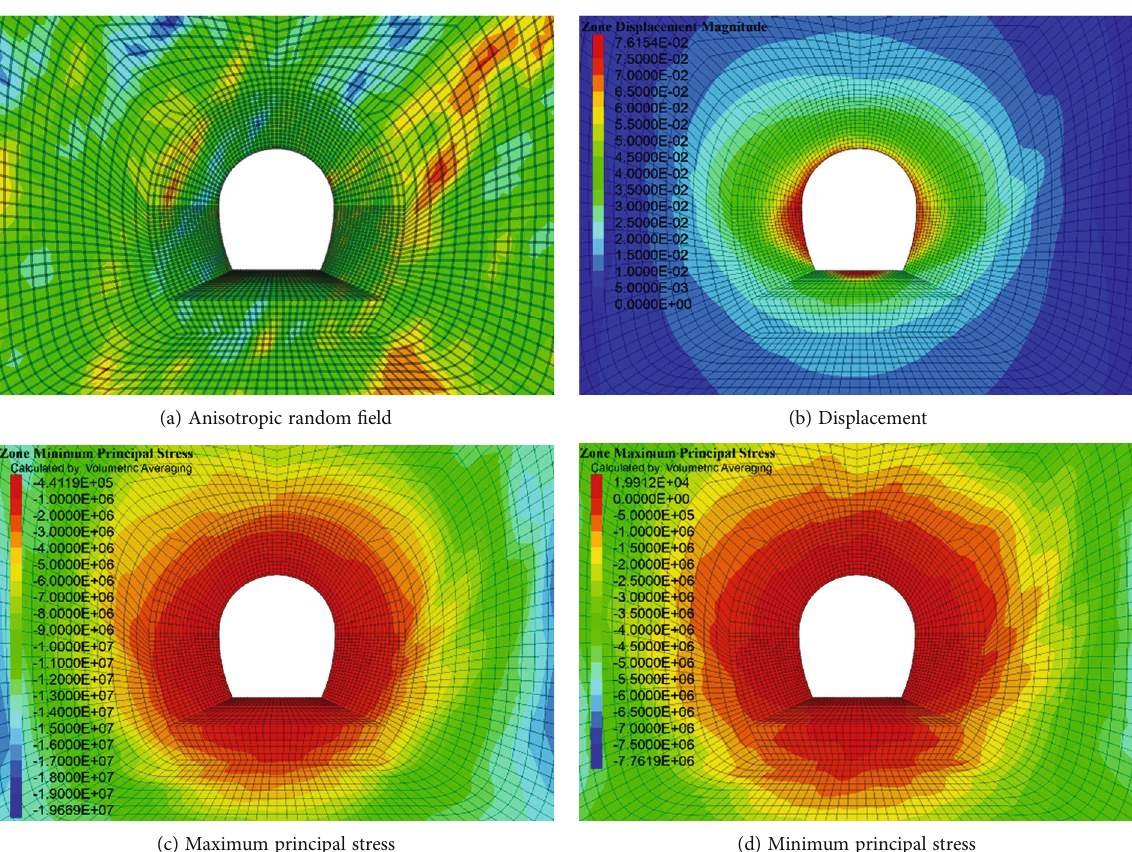
Figure 13: Analysis of cavern excavation results with 60 ° anisotropic fi